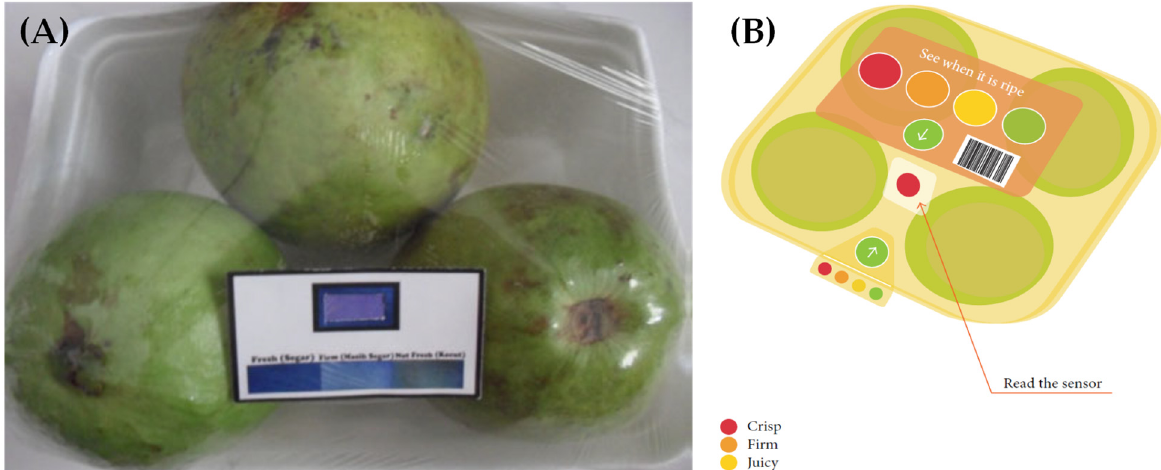
Figure 4. ( A ) Application of the freshness indicator for guavas packaging [49], reproduced with permission from [49]. ( B ) Schematic representation of the RipeSense indicator, reproduced from [35].